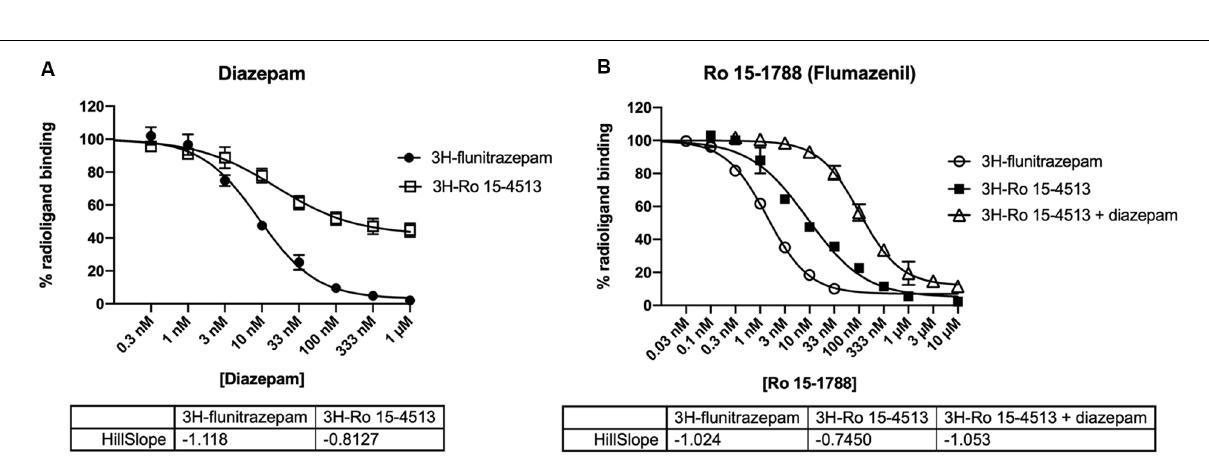
a low-affinity one-site binding with a Hill-slope of − 1